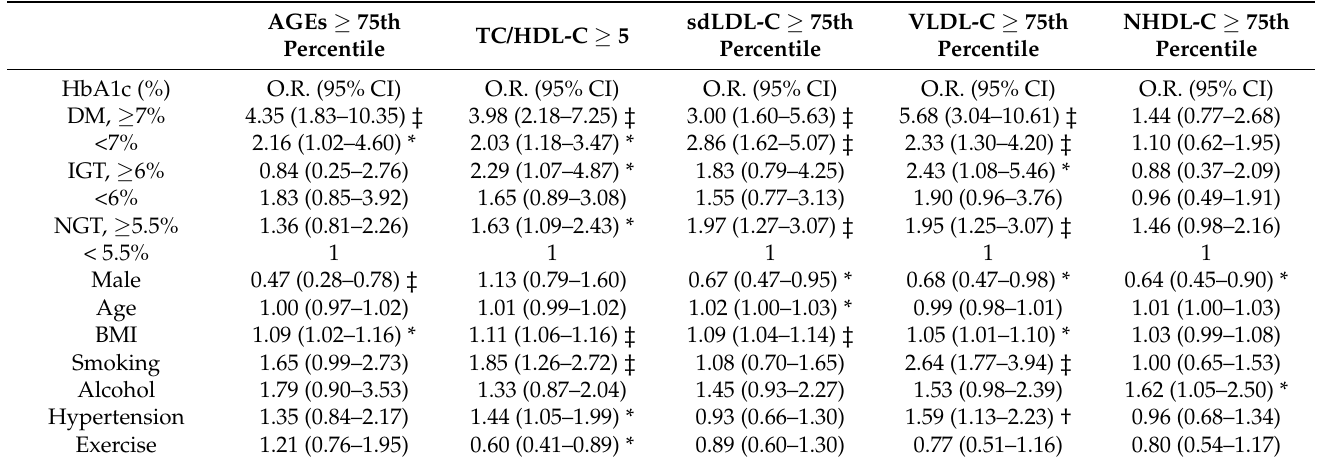
Table 6. Multivariate logistic regression model for all participants, with a cutoff point of HbA1c ≥ 5.5% in the NGT